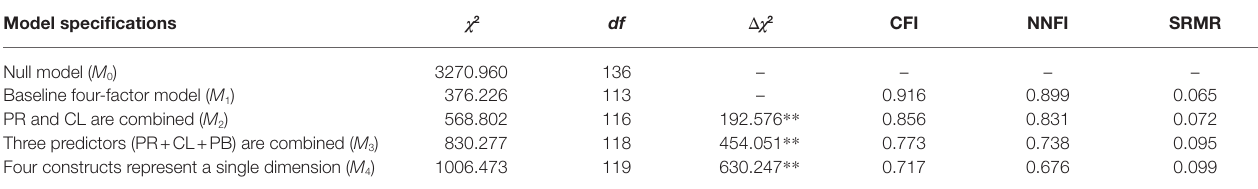
TABLE 1 | Confirmatory factor analyses of the measurement models. Model specifications